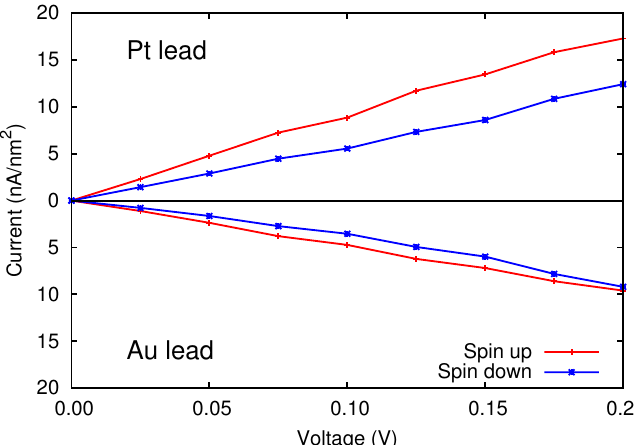
Figure 7. Spin resolved current of the asymmetric devices, as a function of the applied bias voltage.